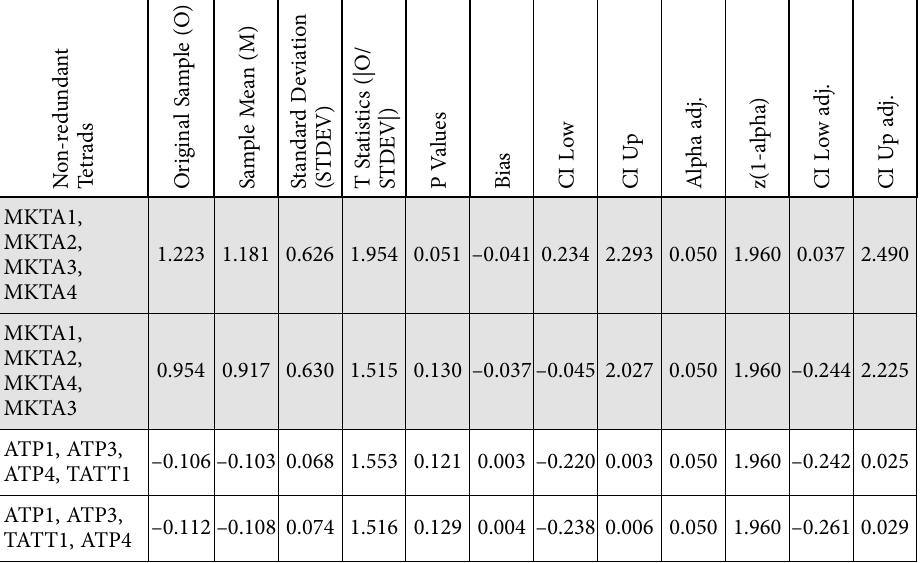
Table 1. Results of CTA-PLS analysis for non-redundant tetrads